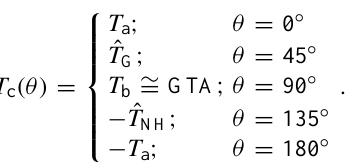
Here, we define T c (θ) as T c (θ) = T a cos θ + T b sin